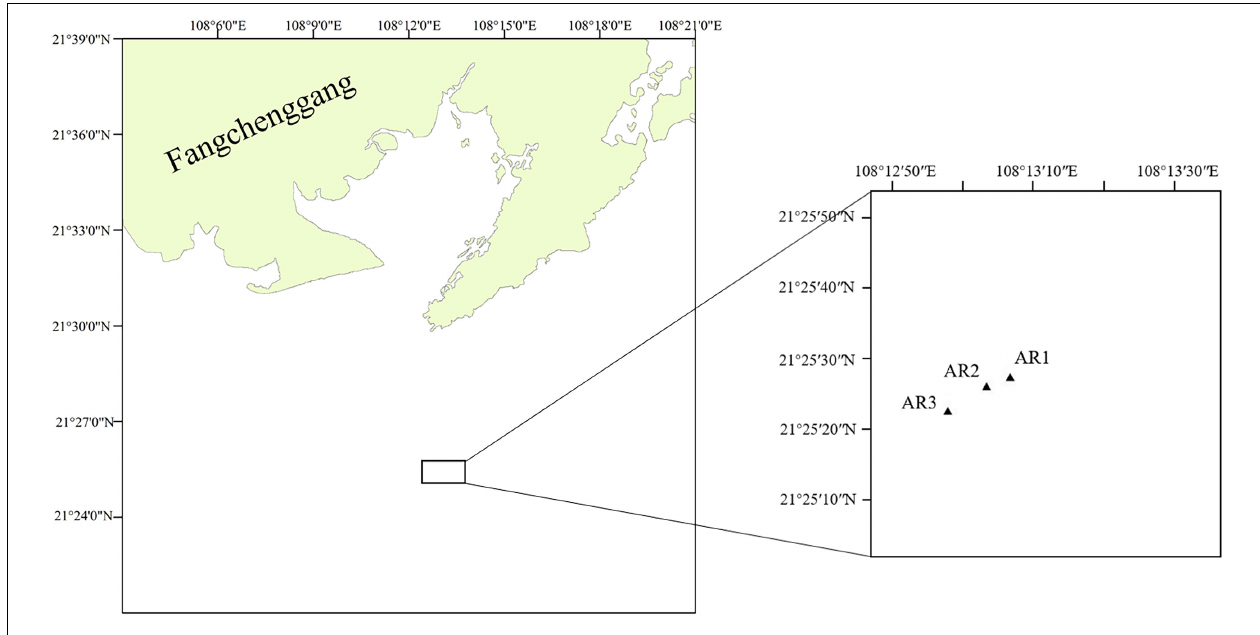
FIGURE 1 | Sampling sites in Bailong Pearl Bay: artificial reef areas (AR1–AR3).